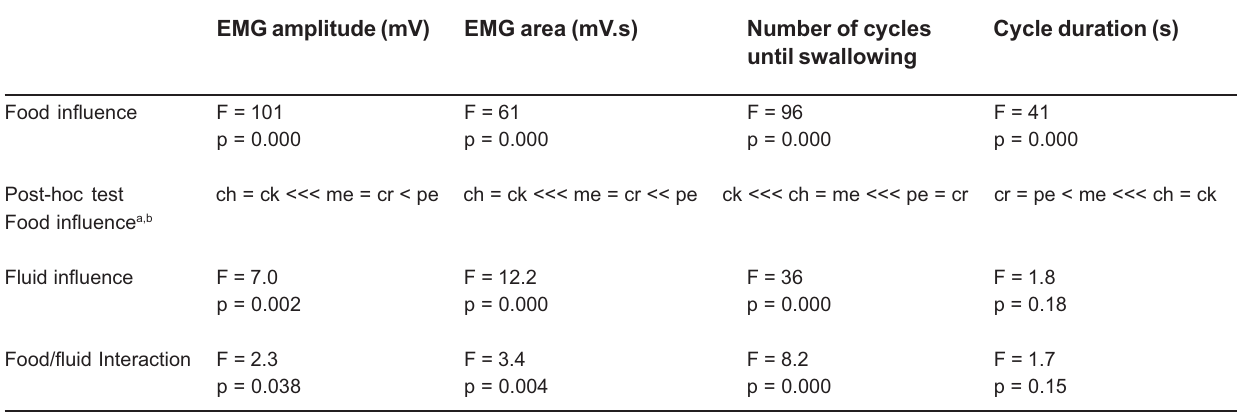
TABLE 1- Influence of foods and fluids on chewing physiology parameters